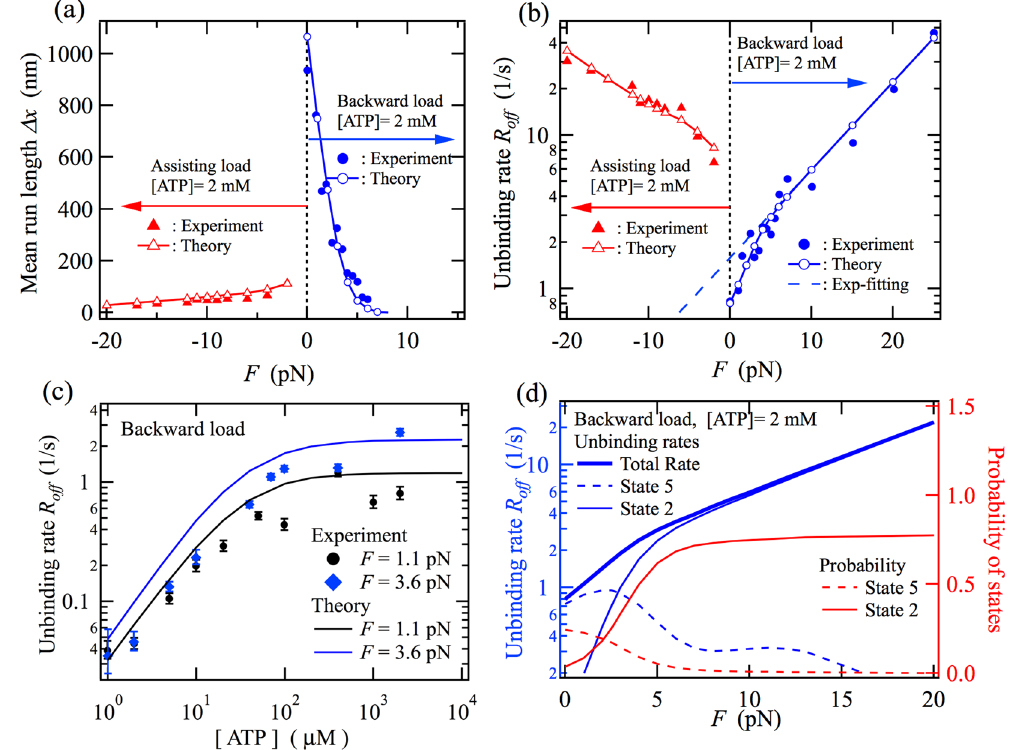
Figure 5. Force dependences of ( a ) mean run length Δ x and ( b ) unbinding rate R off at a saturated ATP concentration of 2 mM. ( c ) ATP-concentration dependence of R off at backward loads of 1.1 pN and 3.6 pN. ( d ) (Left axis) Backward load dependence of partial unbinding rates from states 2 and 5 at 2 mM ATP; (right axis) the backward load dependence on the probabilities of states 2 and 5 at an ATP concentration of 2 mM. The experimental data shown in Fig. 5a and b are from the literature 50 . The experimental unbinding rates shown in Fig. 5c were calculated using = ∆ R v x / , with the experimental data 48 . In Fig. 5b, the broken line shows an off exponential fit to the theoretical results under backward loads greater than 10